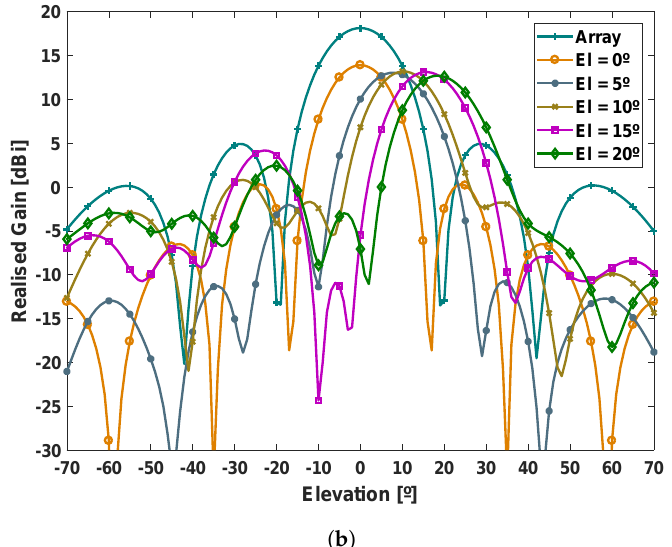
Figure 5. Simulated output angular sweep in the ( a ) azimuth and ( b ) elevation planes, respectively.